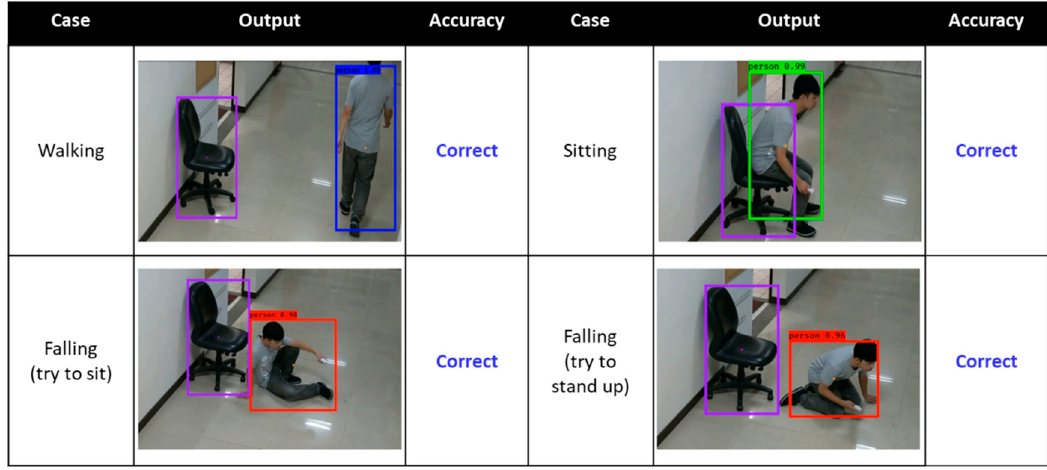
Figure 17. The results of the high-angle shot test case.